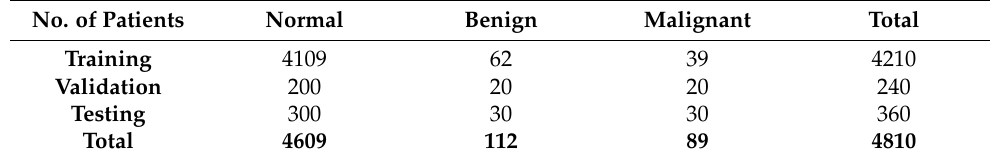
Table 1. Number of cases in each category from the (BCS-DBT) dataset [29–31].